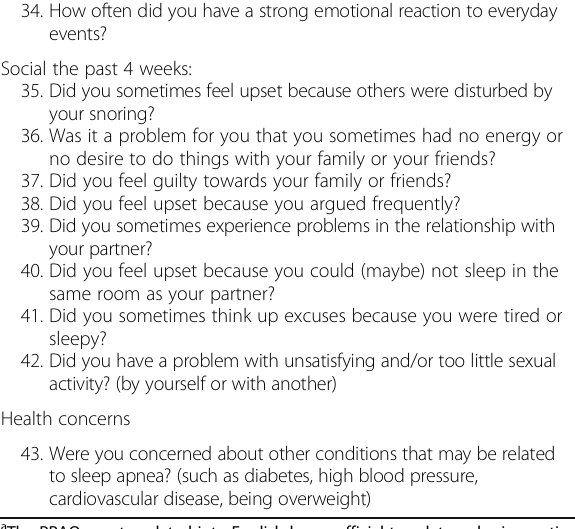
Table 3 English translation of preliminary PRAQ a